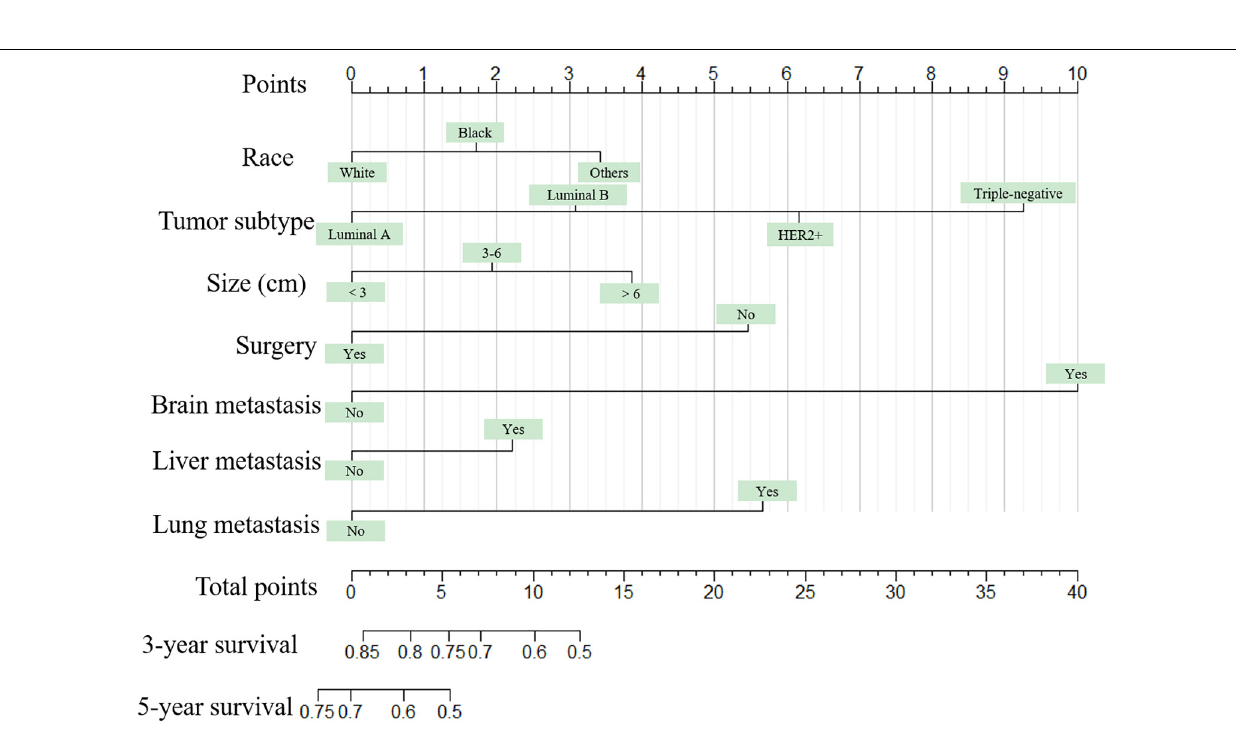
FIGURE 2 | The graph shows the nomogram predicting 3- and 5-year cancer-specific survival of young women with breast cancer bone metastasis. The nomogram summed the points identified on the scale for each predictor. The total points projected on the bottom scales indicate the probabilities of 3- and 5-year overall